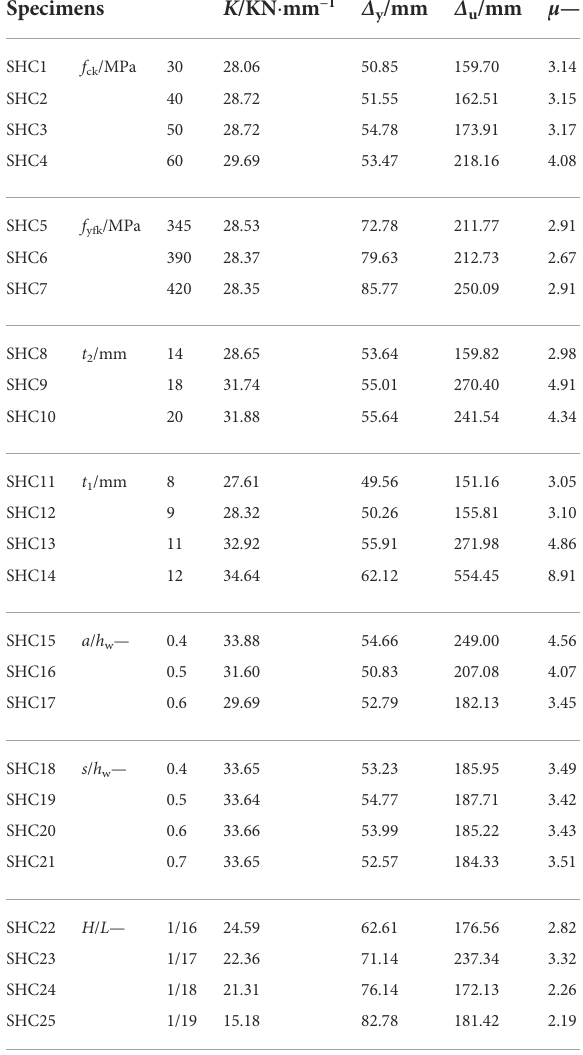
TABLE 4 K and µ for SHC with different parameters.